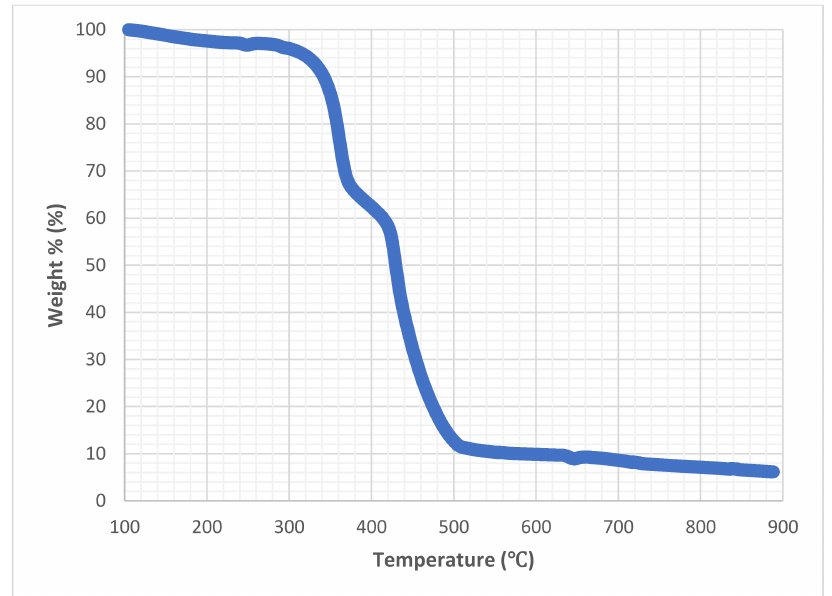
Figure 6. TGA Curve of MCC.